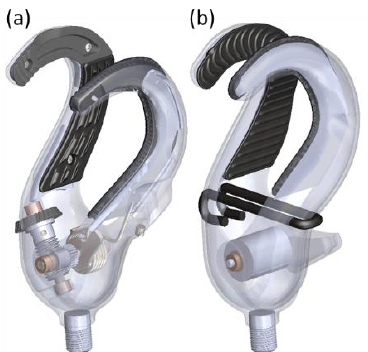
Figure 3. ( a ) Worm gear crown mechanism concept, ( b ) tubular band mechanism concept.